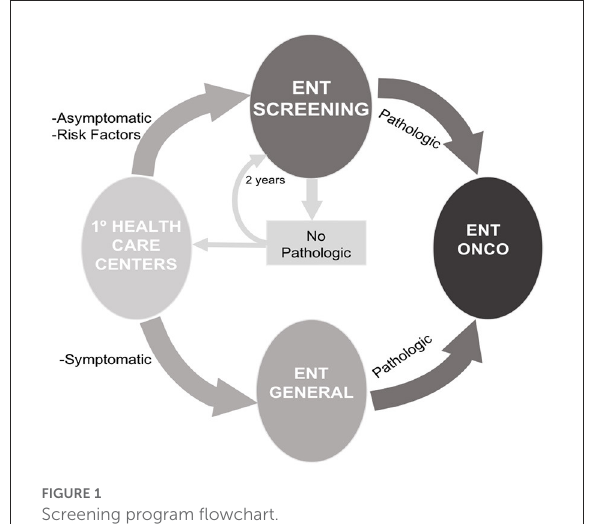
FIGURE1 Screening program